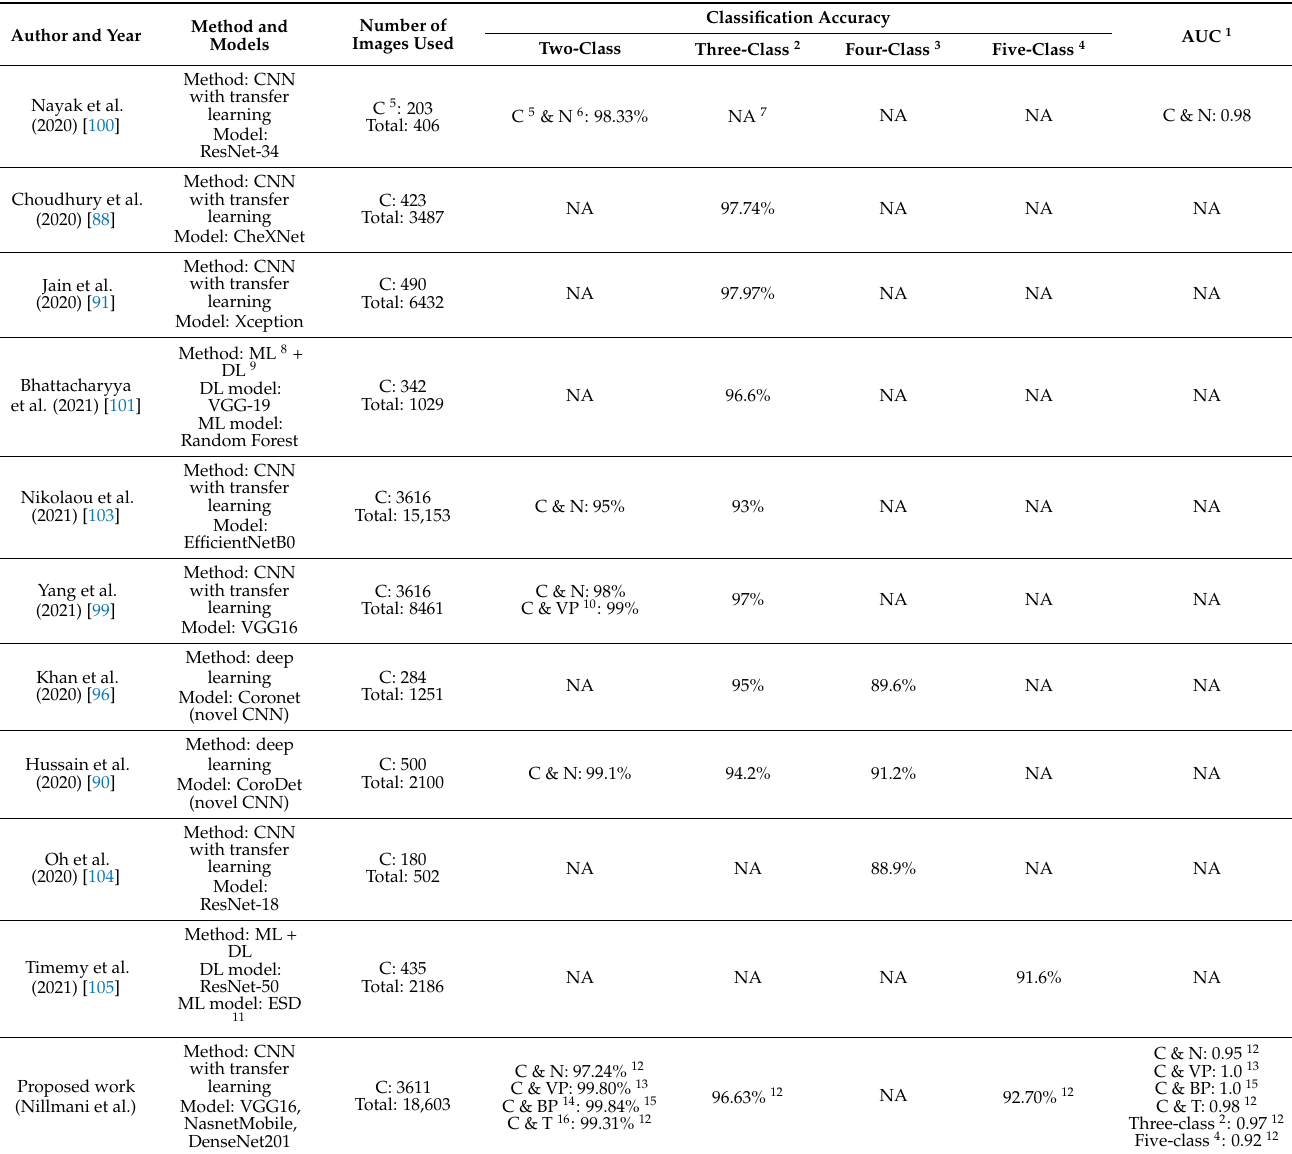
Table 9. Benchmarking table showing state-of-the-art methods and comparing them against the proposed